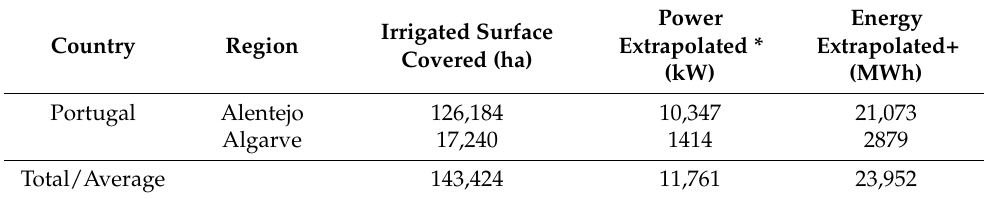
Table 6. Power and energy potential estimates for MHP from the analysis of regions containing pressurised irrigation networks in Portugal. Power Energy Country Region Covered (ha)